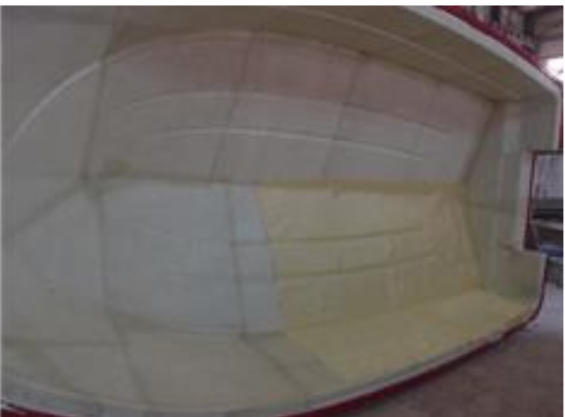
Figure 15. Laminate of hull structure.